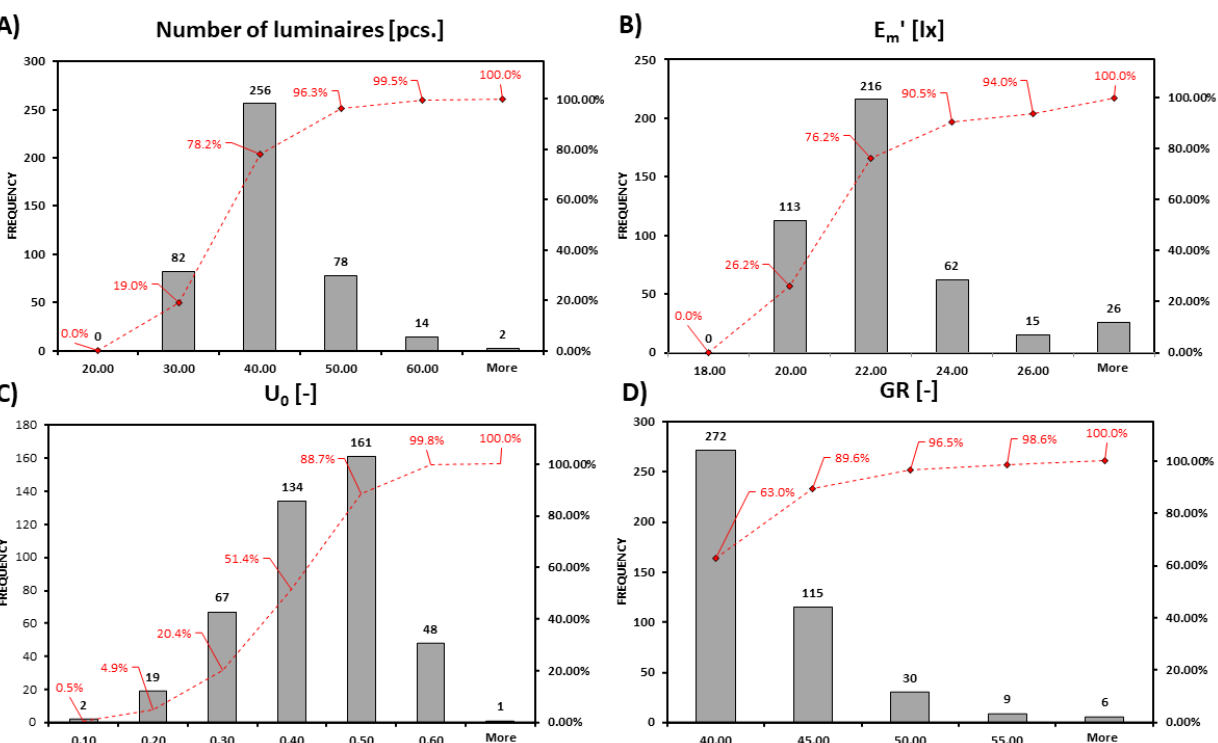
Figure 5. The histograms presenting the distribution of obtained results for: ( A )—number of luminaires, ( B )—average illuminance (including maintenance factor), ( C )—uniformity of illuminance, and ( D )—glare rating.